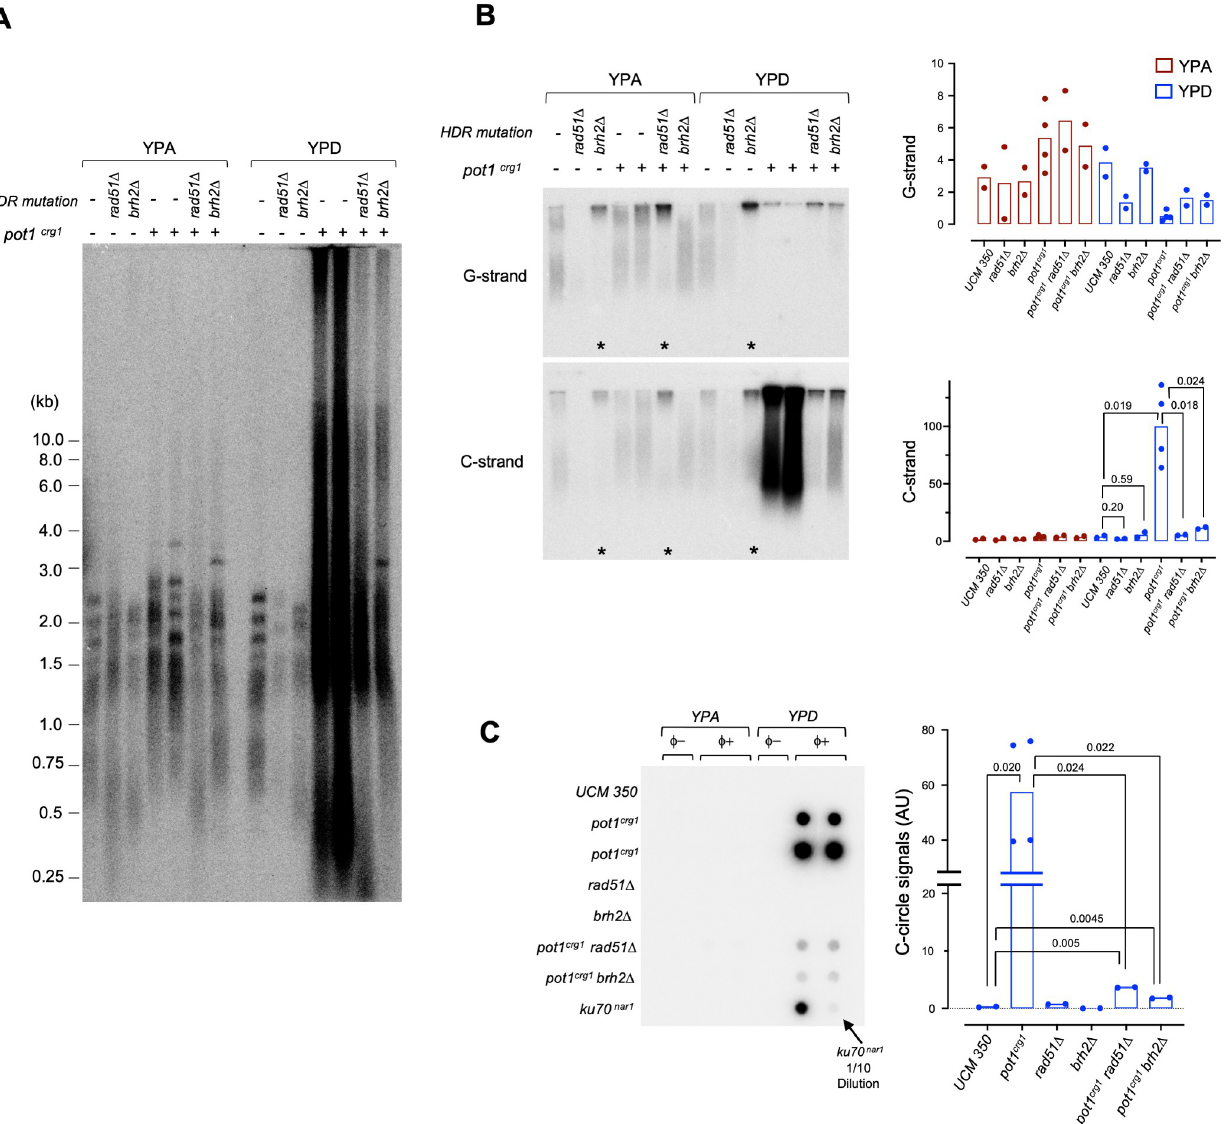
Fig 5. Telomere aberrations in pot1 -deficient U . maydis are greatly suppressed by rad51 Δ and brh2 Δ . A. Chromosomal DNAs from the indicated wild type and mutant strains grown in YPA and YPD were subjected to telomere restriction fragment analysis. Two independently generated pot1 crg1 strains were analyzed in all the assays in this figure. B. Chromosomal DNAs from the indicated wild type and mutant strains grown in YPA and YPD were subjected to in-gel hybridization analysis of ssDNA on both the G- and the C-strand (left). The levels of ssDNA from two independent sets of assays were quantified and plotted (right). P-values were calculated using two-tailed Student’s t tests and displayed. C. Chromosomal DNAs from the indicated wild type and mutant strains grown in YPA and YPD were subjected to C-circle assays (left). The relative levels of C-circle signals from these strains were quantified and plotted (right). Data are from two independent sets of assays. P-values were calculated using two-tailed Student’s t tests and displayed.